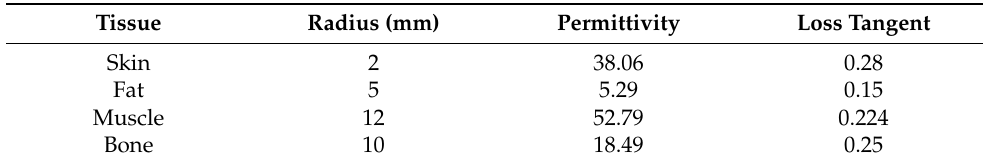
Table 3. Characteristic of four-layer model human’s